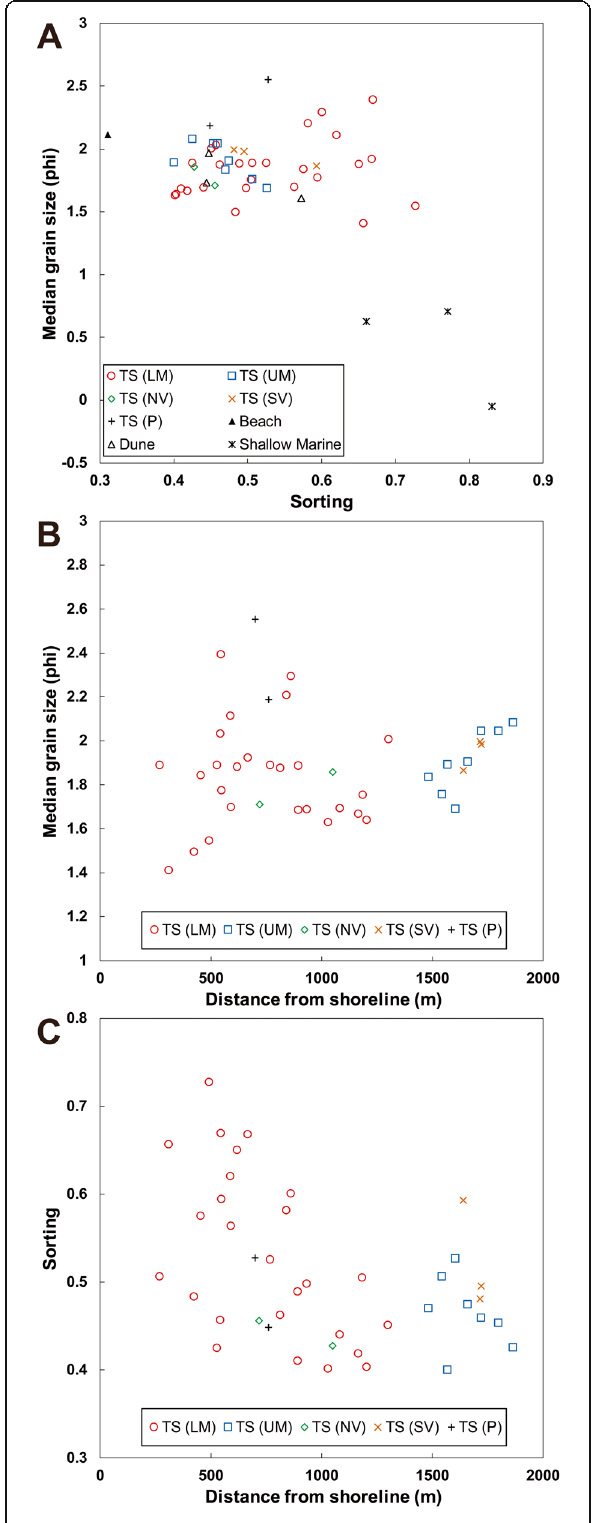
Fig. 7 Median grain size and grain size sorting of tsunami sand, dune sand, beach sand, and shallow marine sand. a Median grain size of sand shown by topographic type against grain size sorting. Results of shallow marine sand sampled off the coast of the valley were from Ohshima et al. (1986). b Median grain size shown by each topographic type against distance from the shoreline. c Grain size sorting shown by each topographic type against distance from the shoreline. Locations of the sampling site are shown in Fig. 1c. TS, tsunami sand layer; LM, lower main valley; UM, upper main valley; NV, north sub-valley; SV, south sub-valley; P,